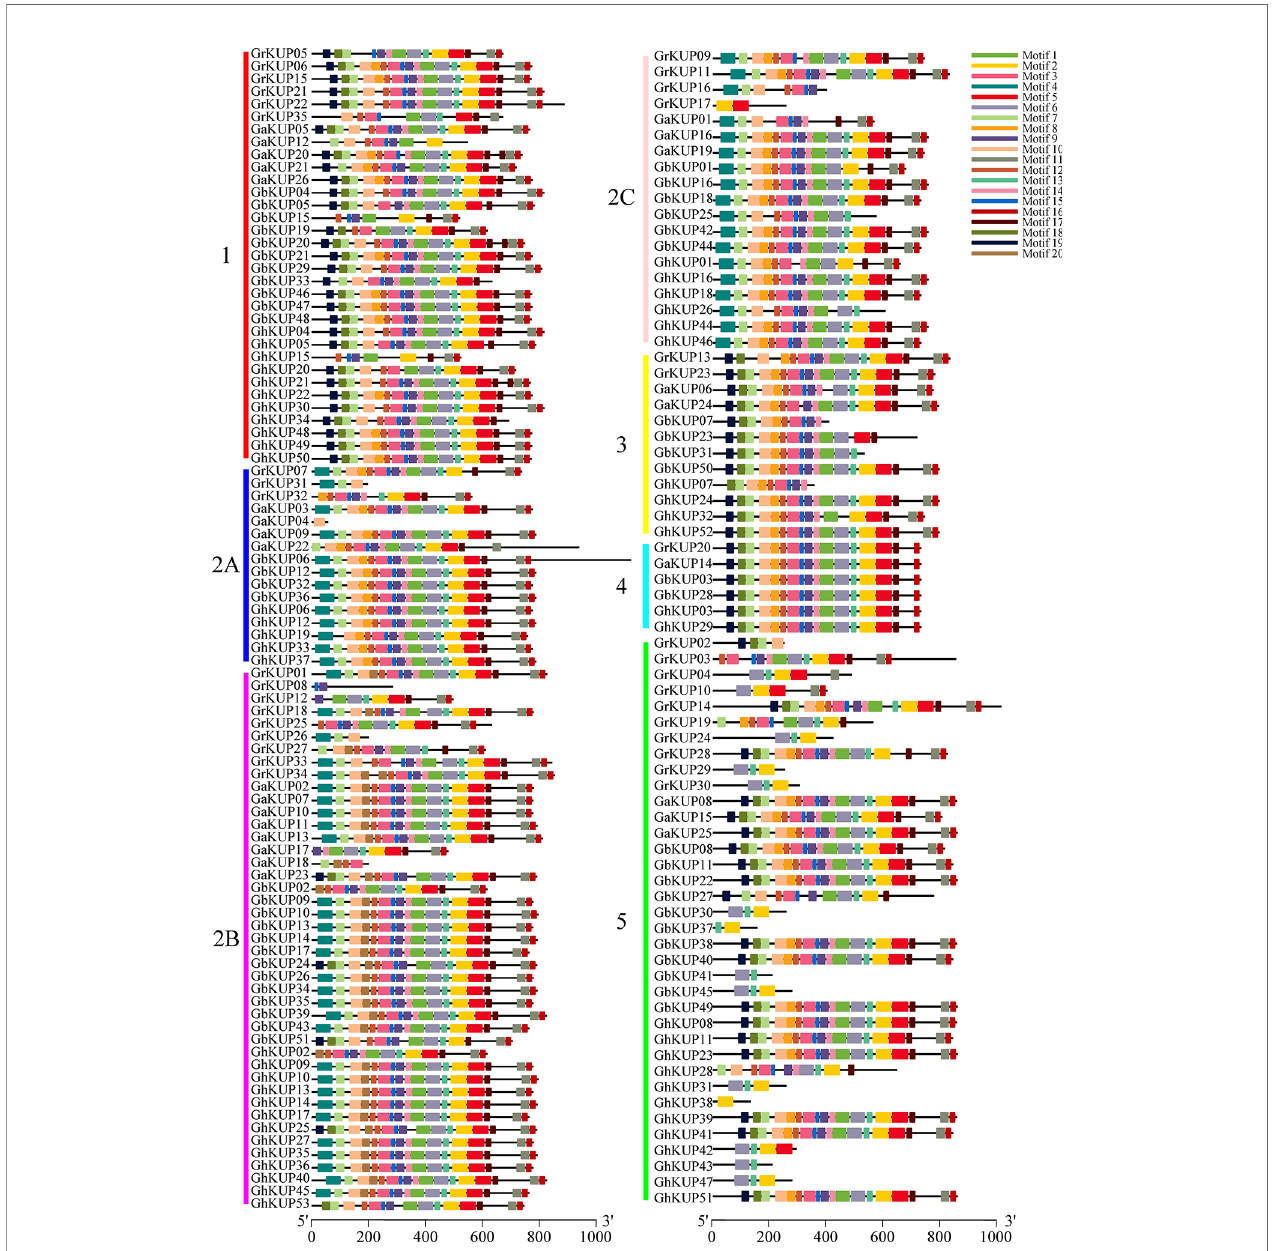
FIGURE 3 | Putative motif distributions of the KUP family in G. raimondii, G. arboreum, G. barbadense , and G. hirsutum . Different motifs are highlighted by colored boxes. KUP subfamilies are indicated by different colors and letters. Motif location can be estimated by using the scale at the bottom of the fi